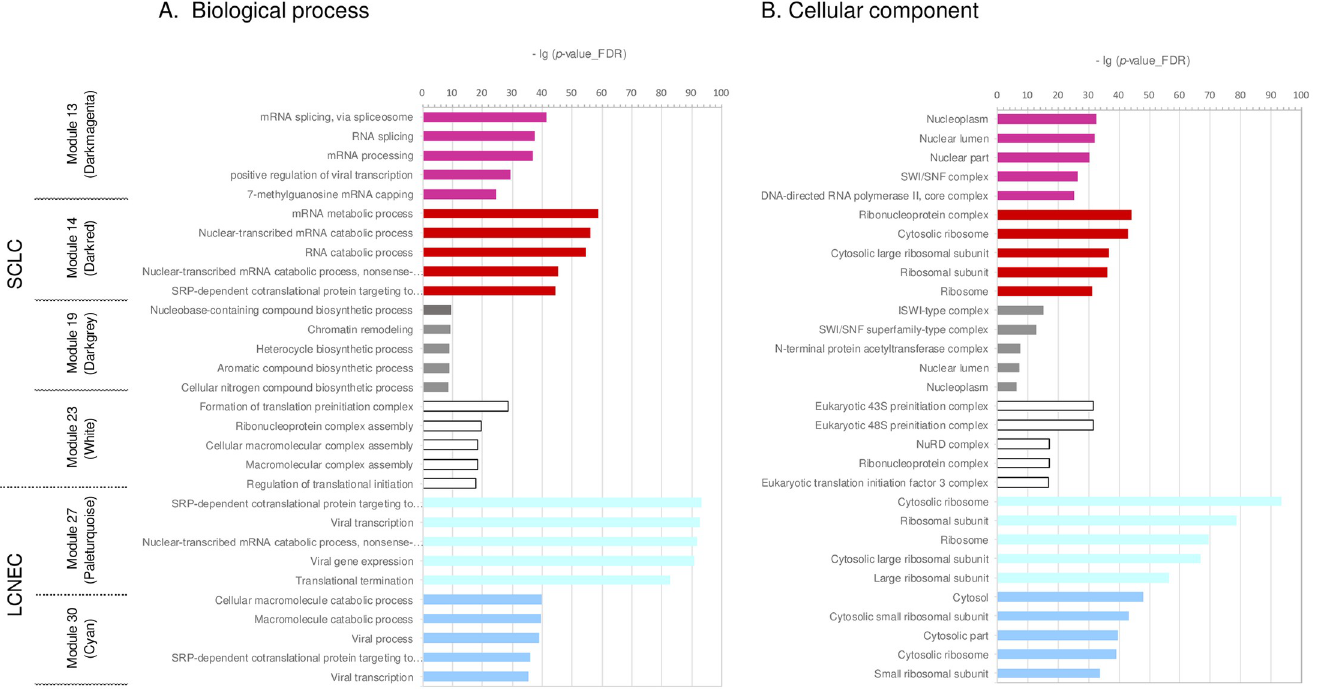
Fig 5. Pathway analysis and top five enrichment results. Enrichment analysis were performed for A. biological processes and B. cellular components by the STRING database for co-expressed genes in the modules of 13 (darkmagenta), 14 (darkred), 19 (darkgray), 23 (white), 27 (paleturquoise), and 30 (cyan). The names of pathways are shown on the left, and the bars on the right represent the − lg ( p -value_FDR) of the corresponding pathway. The different colors of the bars are in accordance with the corresponding modules.